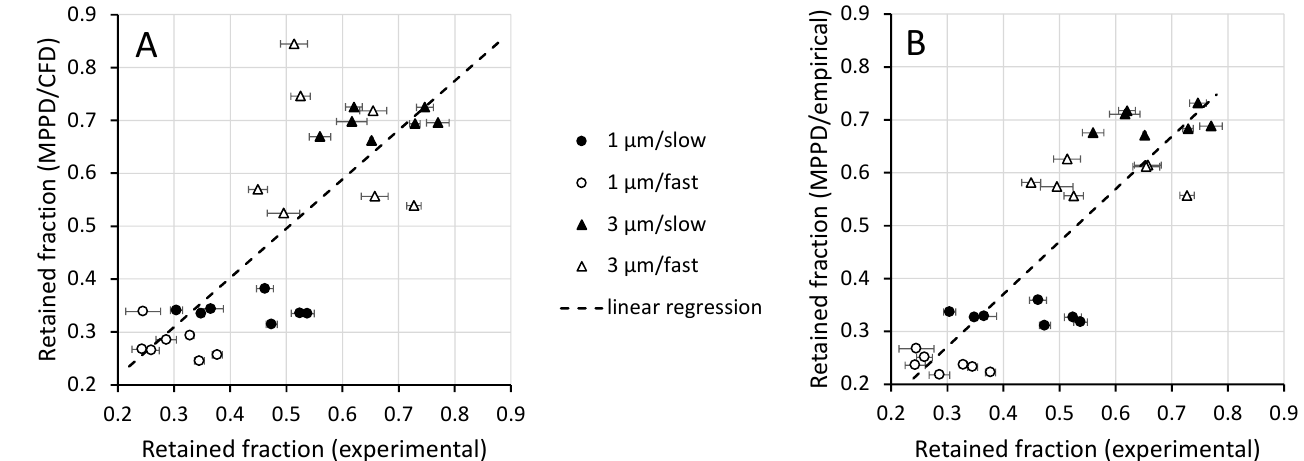
Figure 7. Comparison of in silico predictions with experimental data. Upper airway deposition was predicted by CFD (panel ( A )) or calculated from Equation (4) (panel ( B )). Retained fraction in the intrathoracic lung was obtained from the Multiple-Path Particle Model (MPPD) in both cases. Dashed line: regression line between experimental and predicted retained fraction (R 2 = 61% in panel ( A ) and 73% in panel ( B )). See text for details.